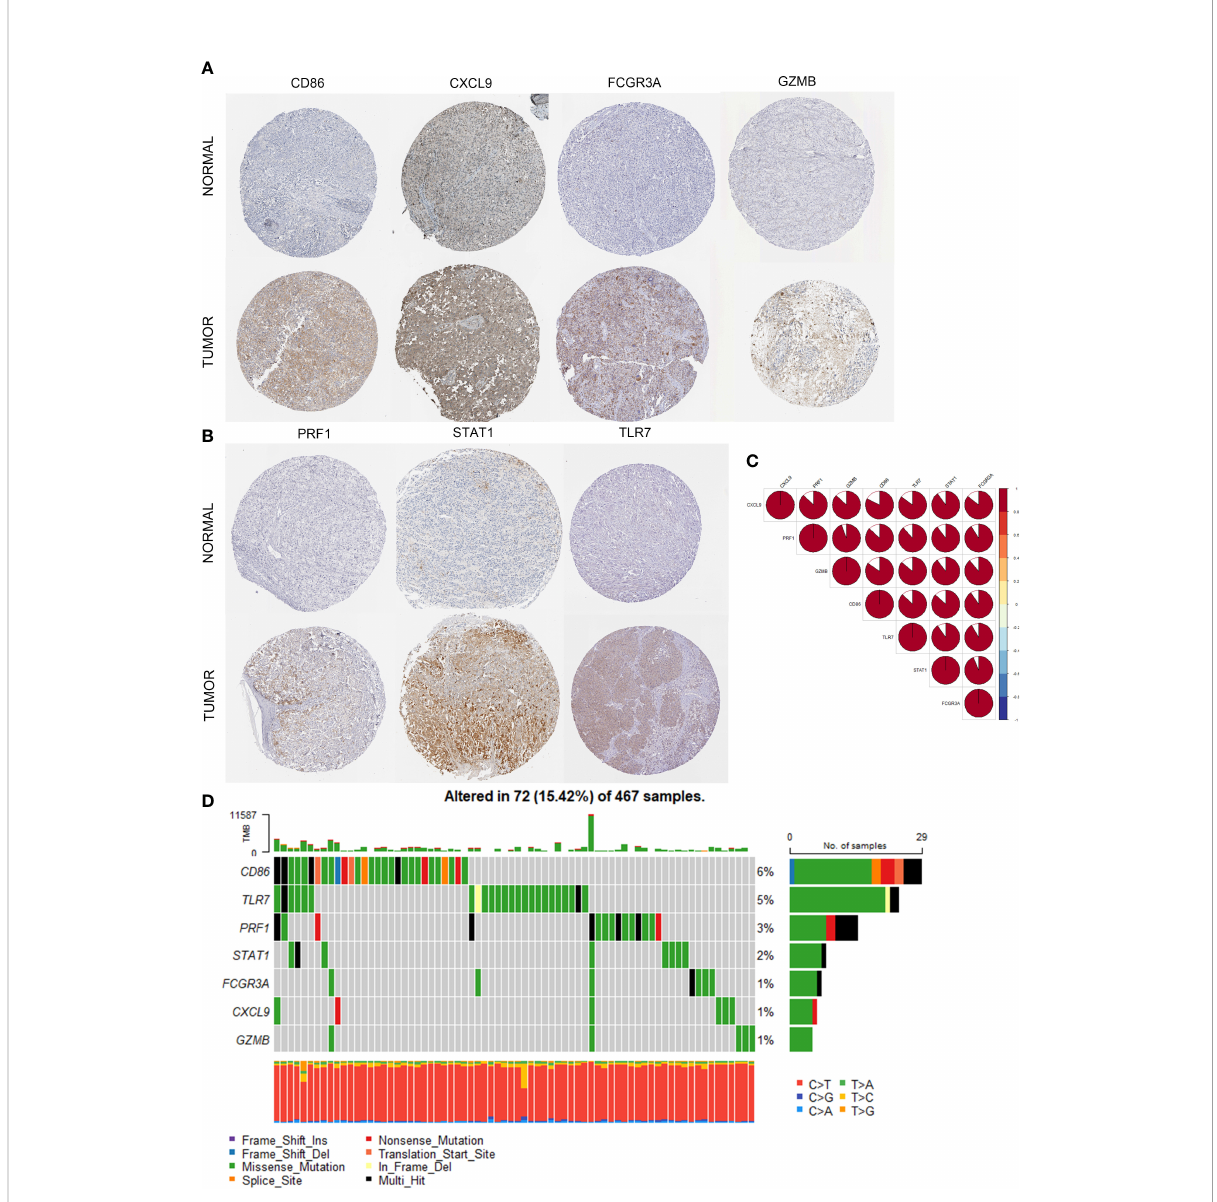
FIGURE 3 Multi-omics analysis of identi fi ed seven key molecules. (A, B) The immunohistochemical staining results revealed signi fi cant differences of key molecules (CD86, CXCL9, FCRG3A, GZMB, PRF1, STAT1, TLR7) at the protein expression between normal skin and cutaneous melanoma obtained at the Human Proteins Atlas. (C) The correlation between the seven key molecules using spearman analysis. The color area represents the magnitude of correlation intensity, red represents positive correlation and blue represents negative correlation. The key molecules in the fi gure show very good correlation with each other. (D) Mutation landscape of seven key molecules in 467 samples of TCGA cohort. Different color modules represent different molecular mutation